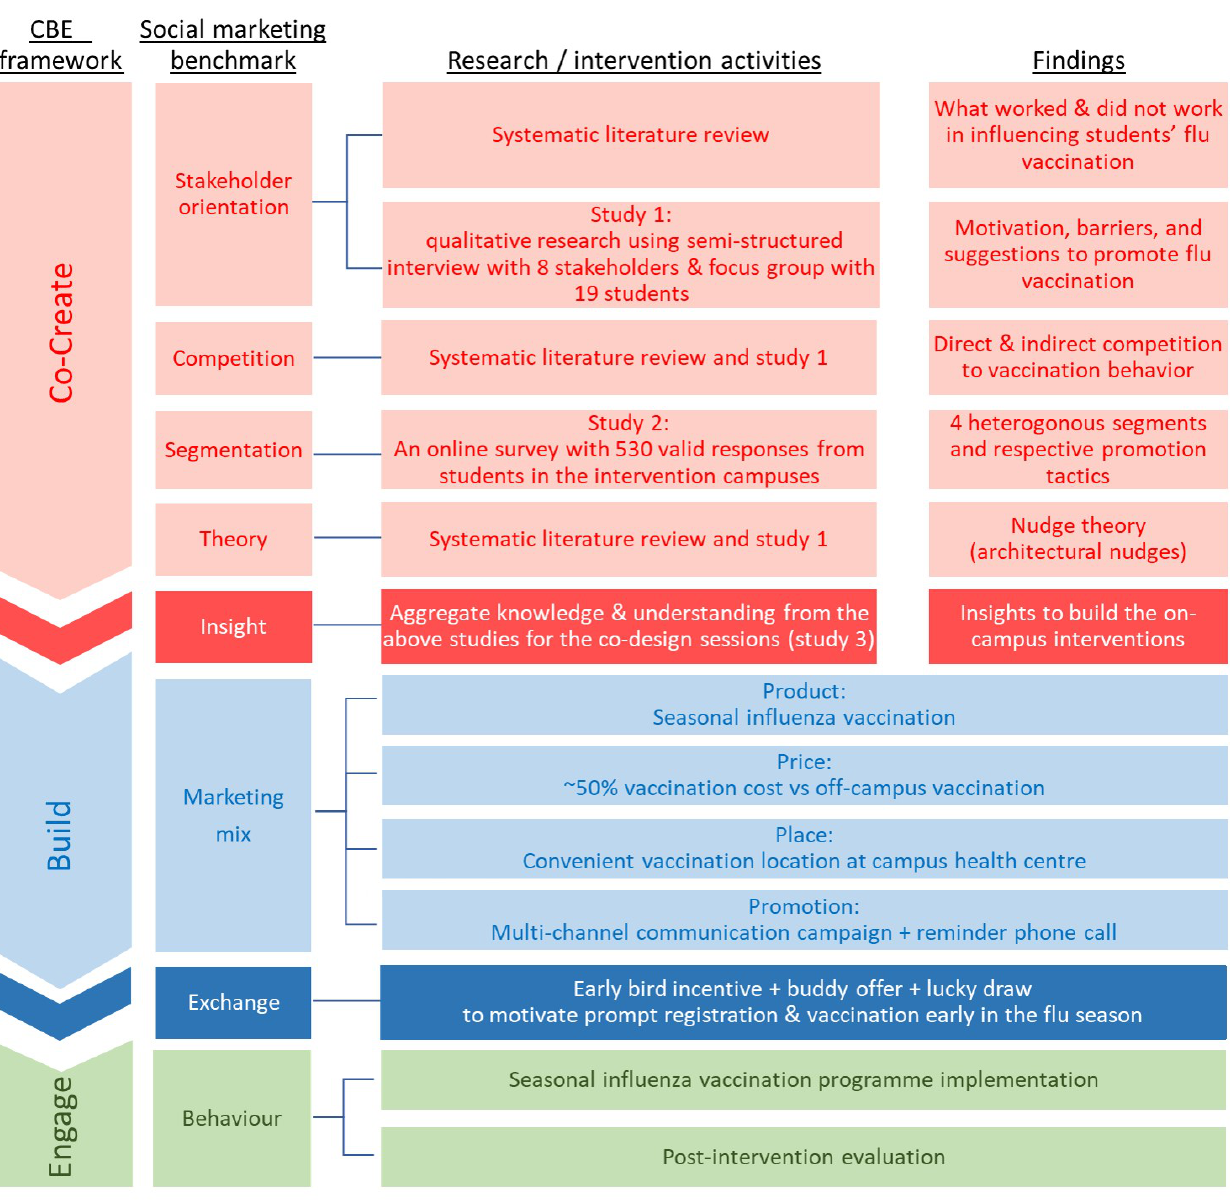
Figure 1. Illustration of intervention design following the CBE